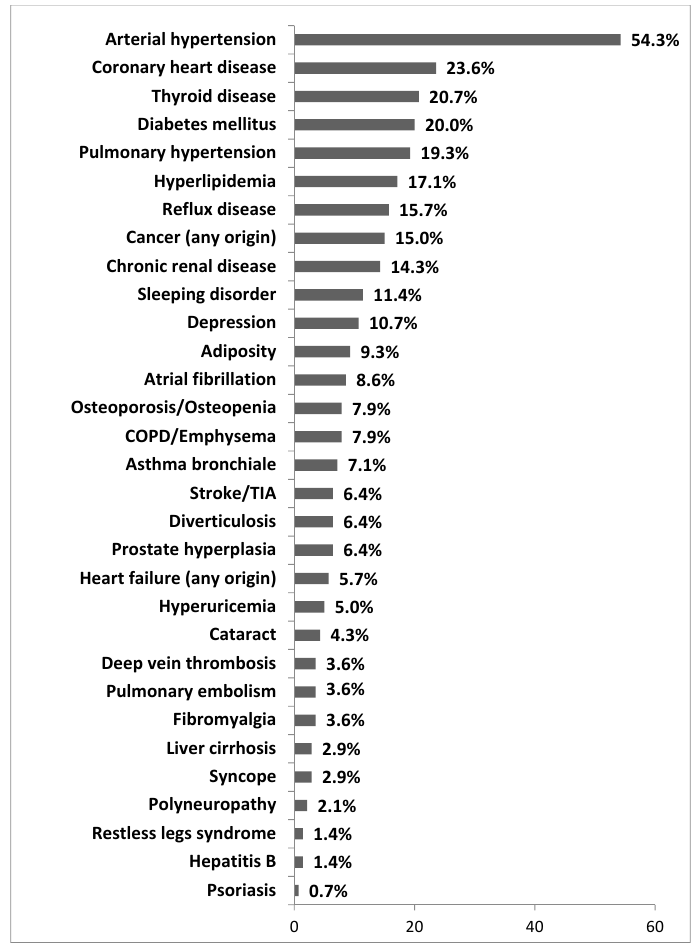
Figure 1. Spectrum of comorbidities in the uILD cohort. Data are given as percentage of all patients. Multiple comorbidities could be reported. Abbreviations: COPD—Chronic obstructive pulmonary disease, TIA—Transient ischemic